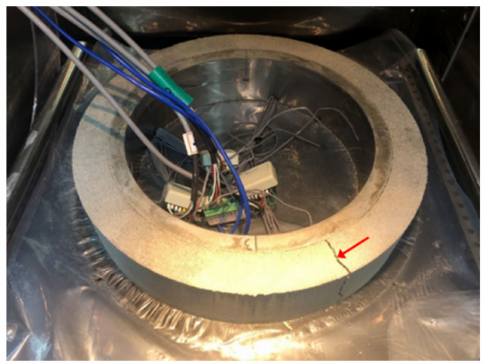
Figure 17. Cracking of mortar ring specimen due to restrained